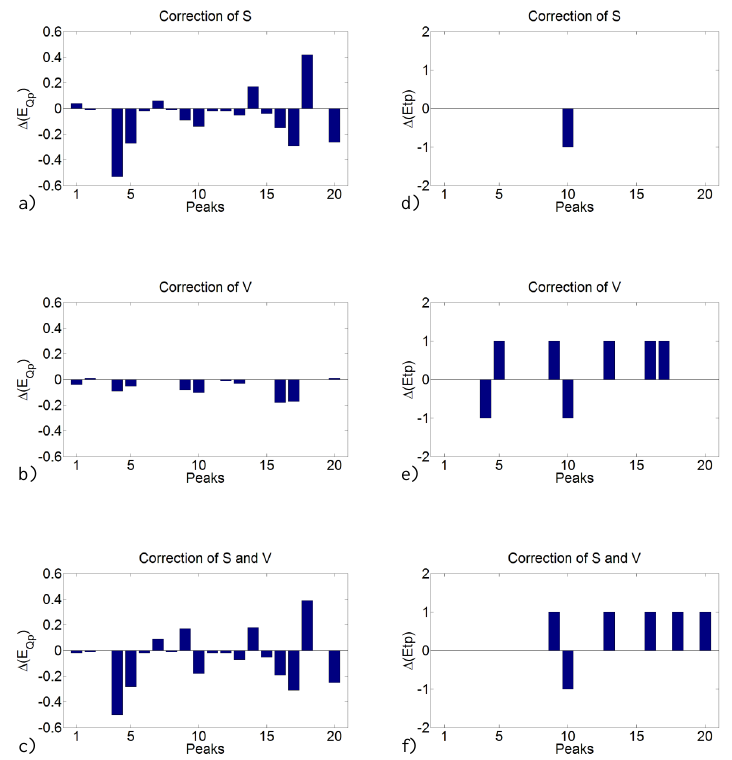
Fig. 4. Histograms that represent the correction efficiency on the estimation of the peak discharge value – histograms (a) , (b) and (c) – and on the estimation of the peak discharge arrival time – histograms (d) , (e) and (f) – for respective correction on S , V and both S and V .